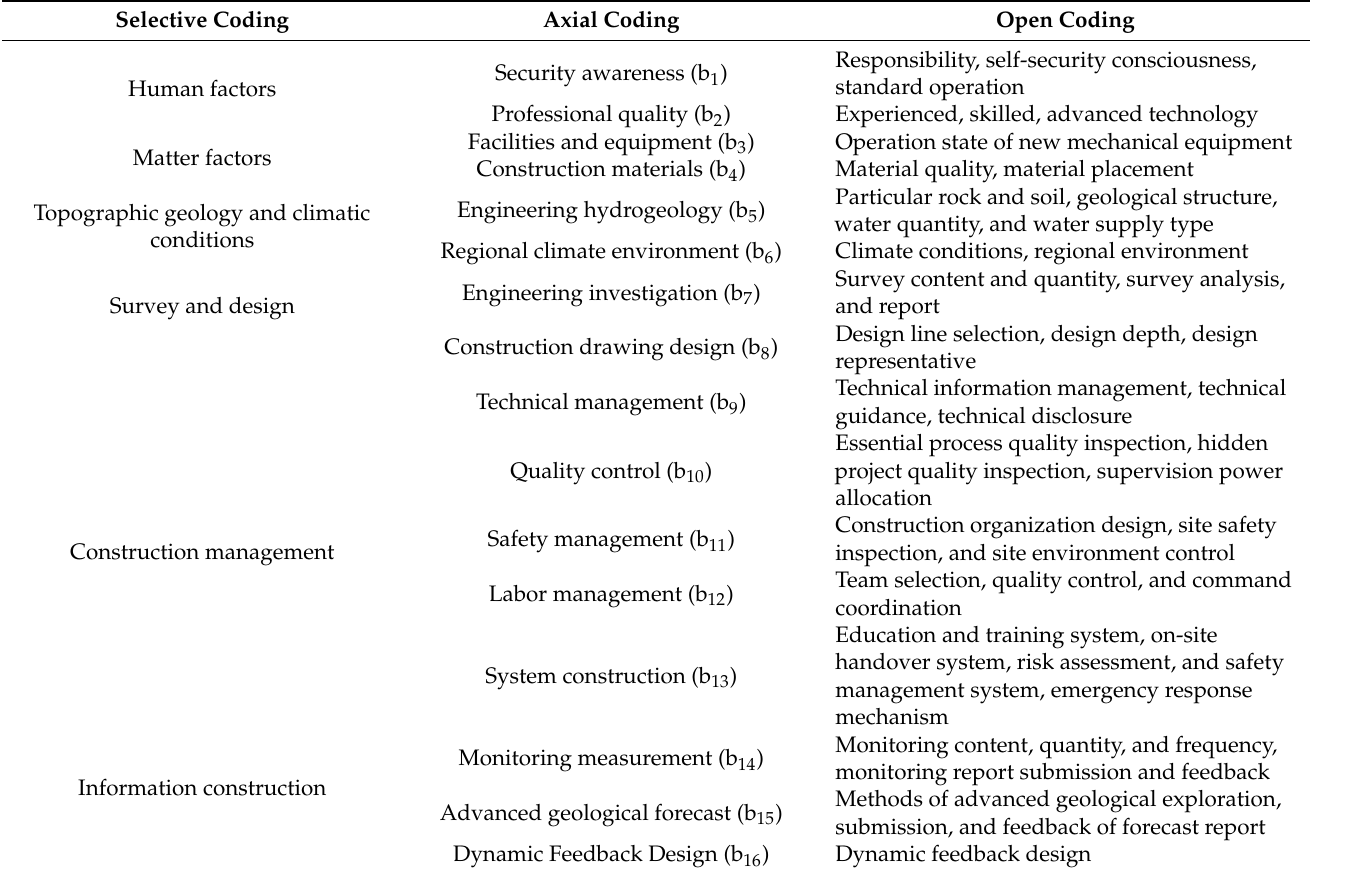
Table 4. Theoretical model of construction safety